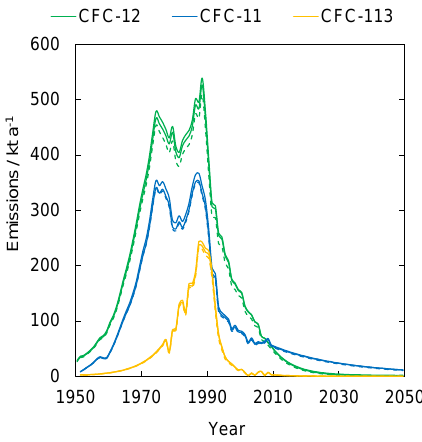
Figure 2. Emissions estimates for CFC-11 (blue), CFC-12 (green) and CFC-113 (orange), based on global tropospheric mole fractions (SPARC, 2013). Each species is represented by three lines. The two emissions estimates from this study (solid lines) are produced using the stratosphere–troposphere exchange flux calculations of Holton (1990) and Appenzeller et al. (1996), with the latter giv- ing slightly higher emissions. These are compared to values from Velders and Daniel (2014) (dashed